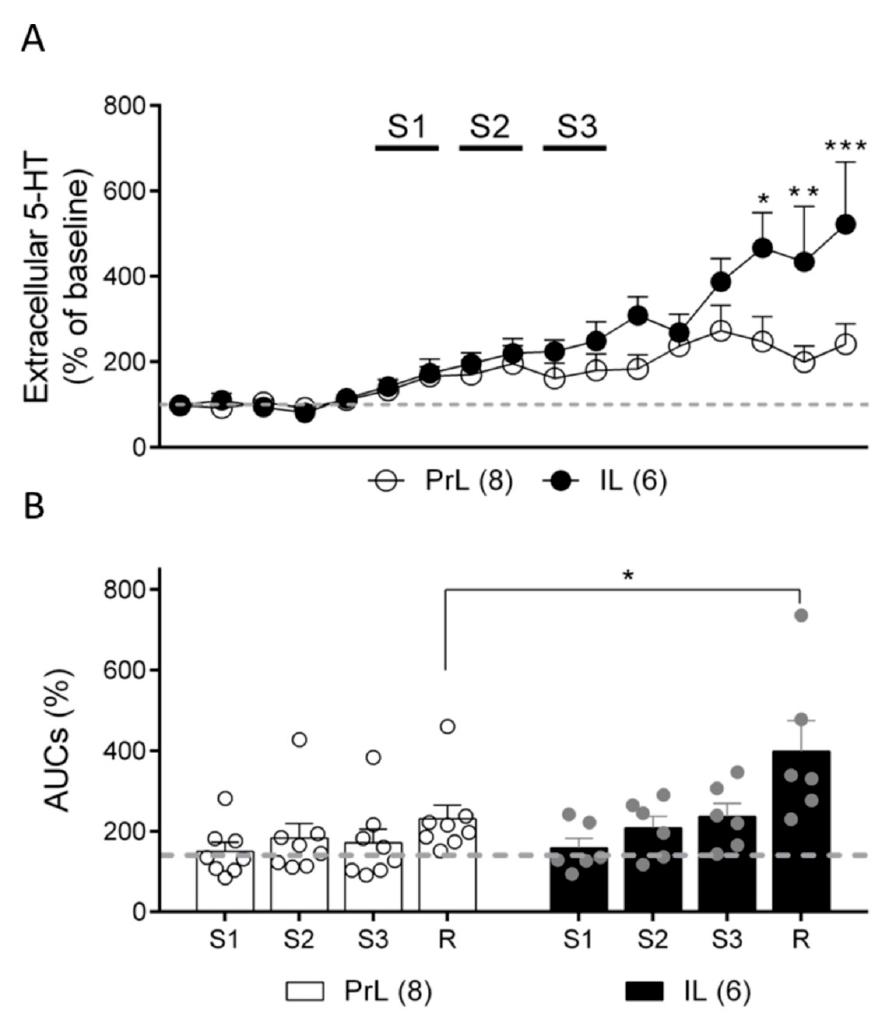
Figure 6. Effect of IL and PrL electrical stimulation (S1: 0.9 Hz, 0.2 ms, 1.7 mA; S2: 10 Hz, 1 ms, 0.5 mA; S3: 20 Hz, 1 ms, 0.5 mA) on extracellular 5-HT concentration in DR. ( A ) Graph shows data as % of basal values averaged from five pre-stimulation samples. Note that both electrical stimulations of IL and